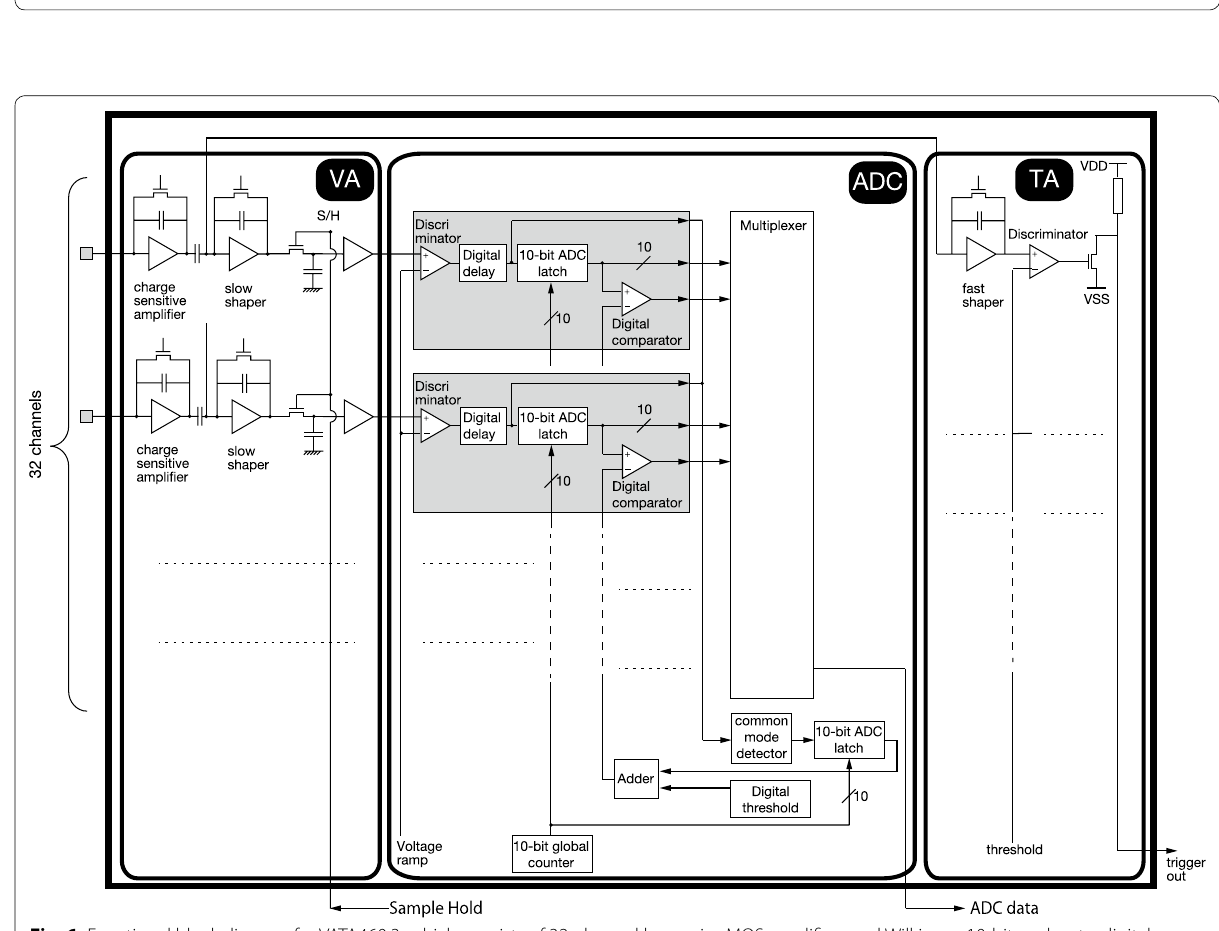
Fig. 5 a Differential fluxes of electrons and protons at L stacked SSD when flux shown in a irradiates stacked SSDs of HEP-L